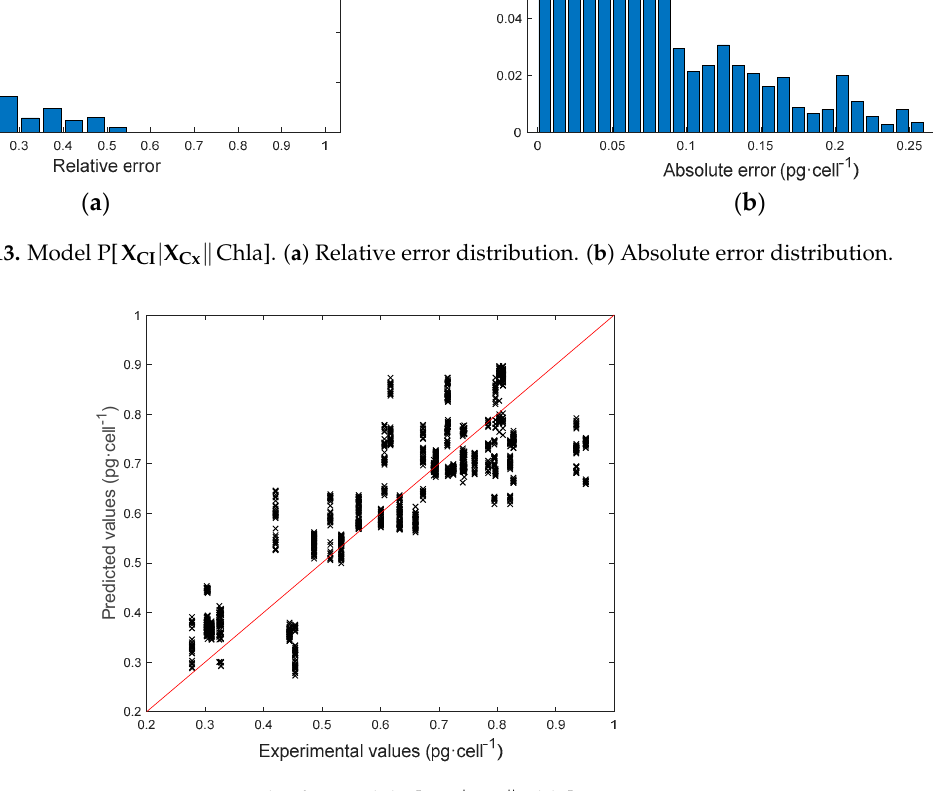
(cid:107) Chla], SSR = 33.76. | X CI Cx